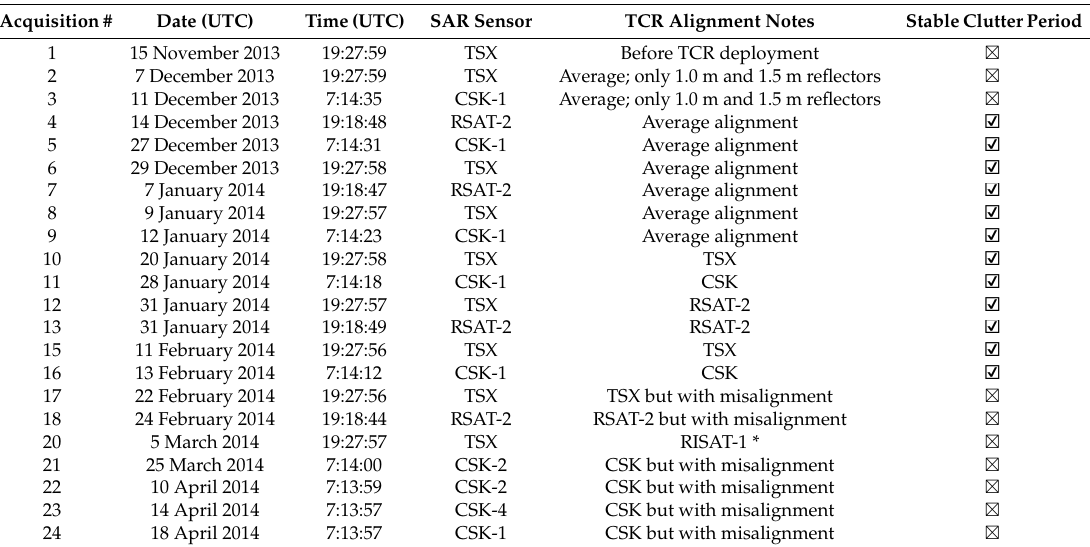
Table 3. SAR acquisitions of the Gunning TCR